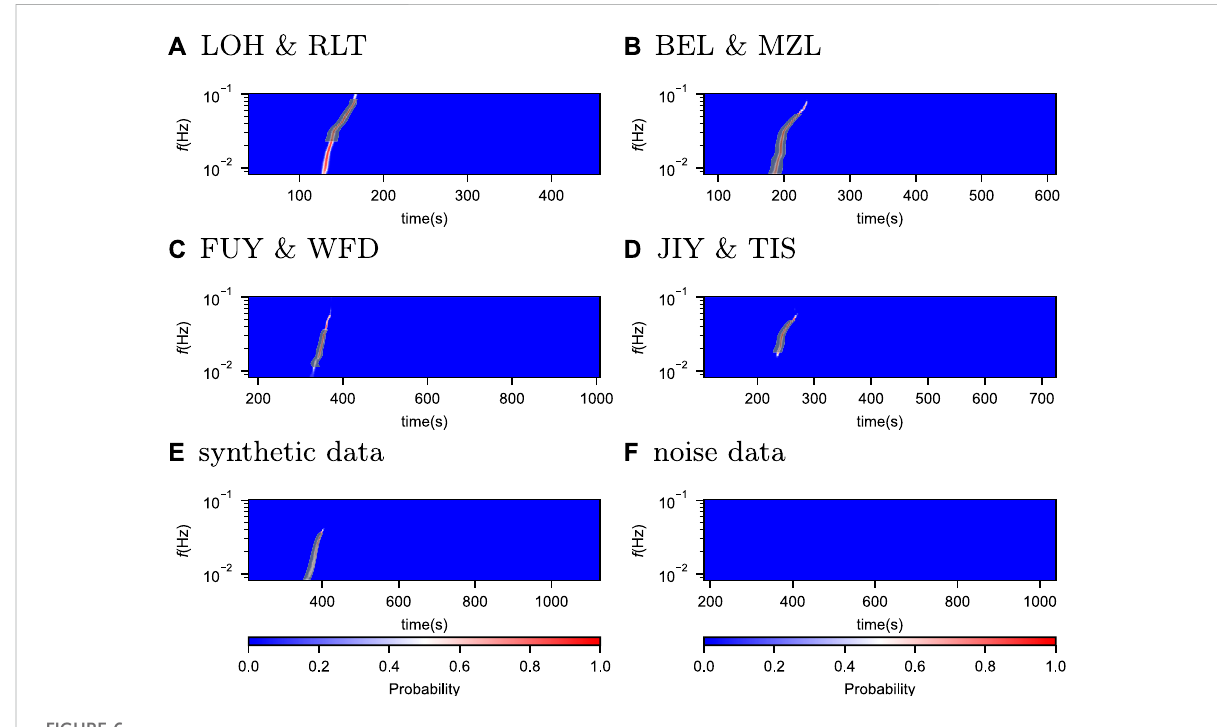
FIGURE 6 Predictions by Surf-Net for the six examples shown in Figure 4. It is in the same presentation way as Figure 4 but with shaded black regions centered around the labeled arrival times with a half-width of 5 times the σ